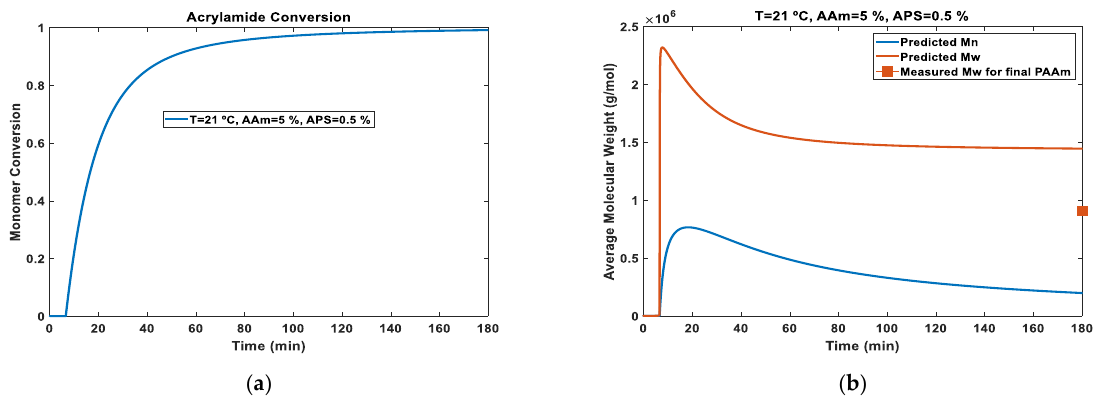
Figure 4. Predicted monomer conversion ( a ) and average molecular weights ( b ) for aqueous acrylamide polymerization at T = 21 ◦ C (the remaining simulation conditions are the same described in [45], namely Y M = 5% and Y I = 0.5%). Main kinetic parameters used in the simulations are those reported in [2,18], and the decomposition rate for APS / TEMED was estimated in order to reproduce the time evolution for monomer conversion reported in [45] (see Table 4). For comparison purposes, the measured value for M w reported in [45] was also included in plot ( b ).